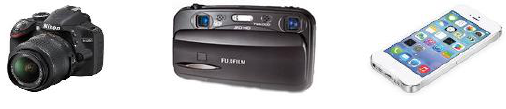
Figure 2 - Sensors that used in this